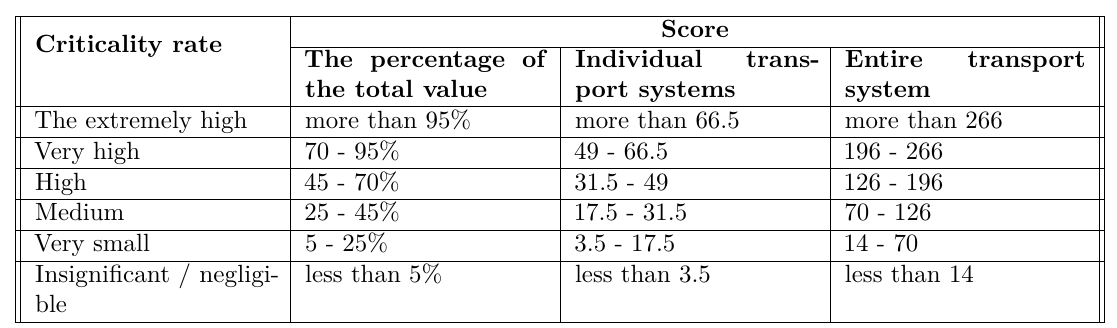
Table 2. Value scale used for determining the criticality